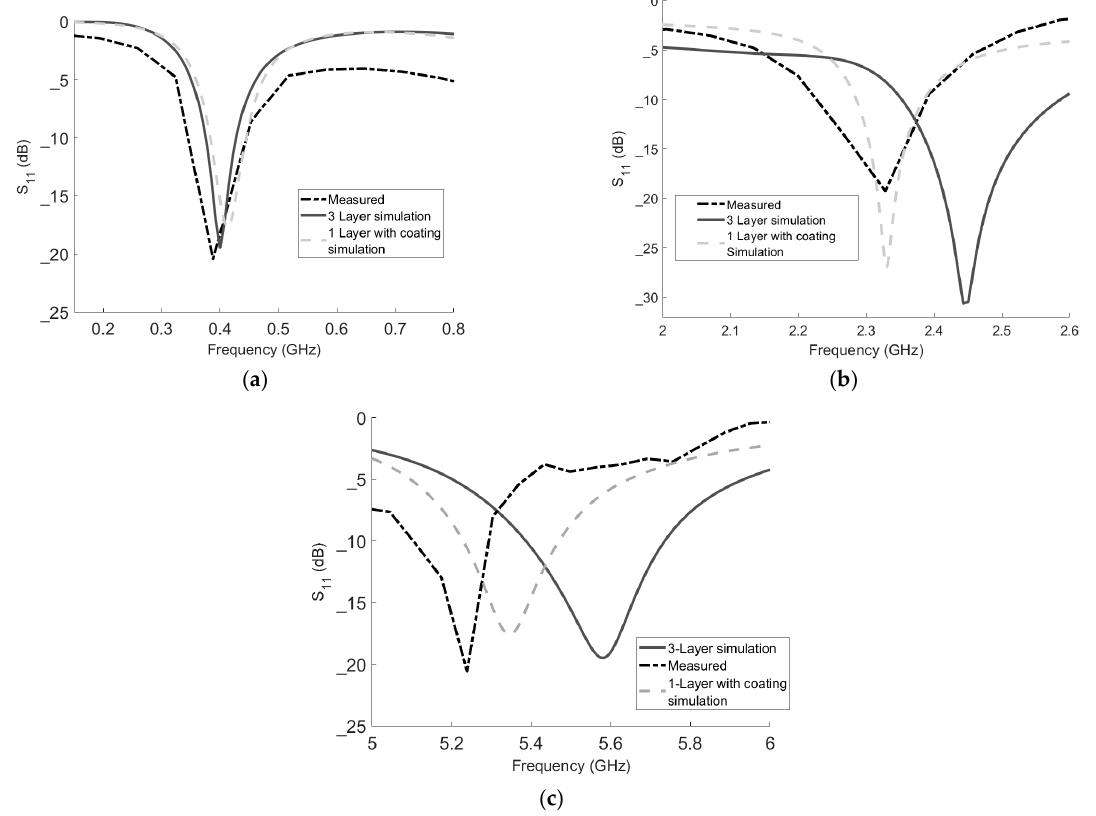
Figure 8. ( a – c ) Measurement of the S 11 of the fabricated meandered antenna in the equivalent phan ‐ tom along with the simulation results of the three ‐ layer model with no coating layer and the one ‐ layer equivalent phantom with the coating layer at the three bands. phantom along with the simulation results of the three-layer model with no coating layer and the one-layer equivalent phantom with the coating layer at the three